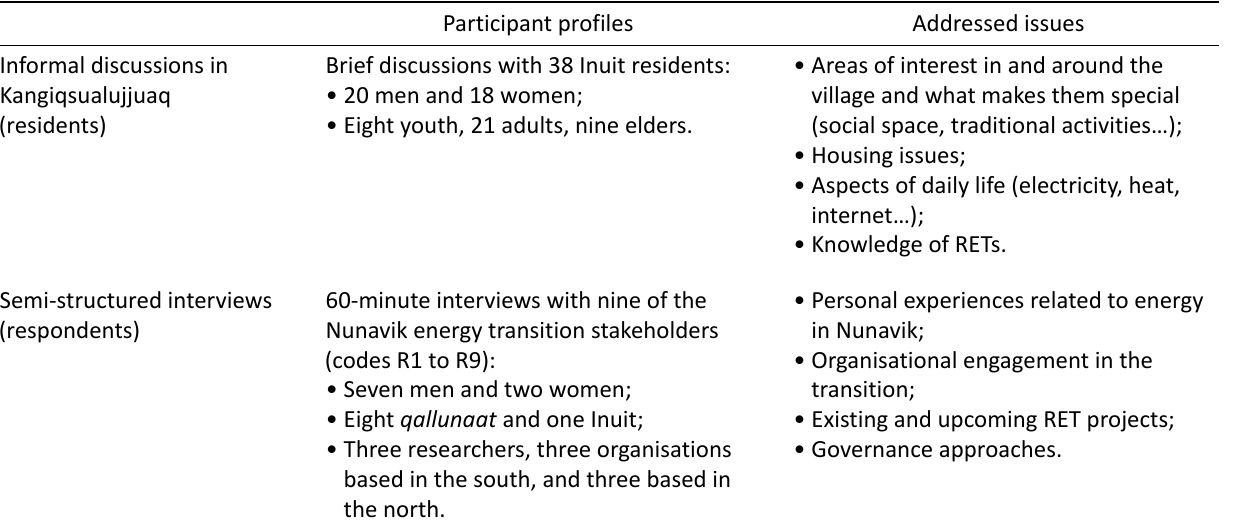
Table 1. Participant profiles and addressed issues.